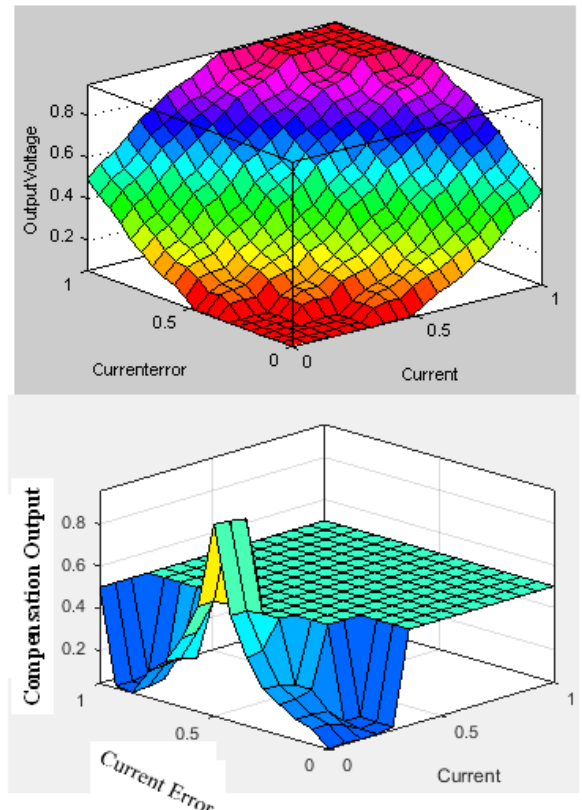
Figure 7. The fuzzy control topology for current compensation and output voltage. Energies 2020 , 13 , x FOR PEER REVIEW